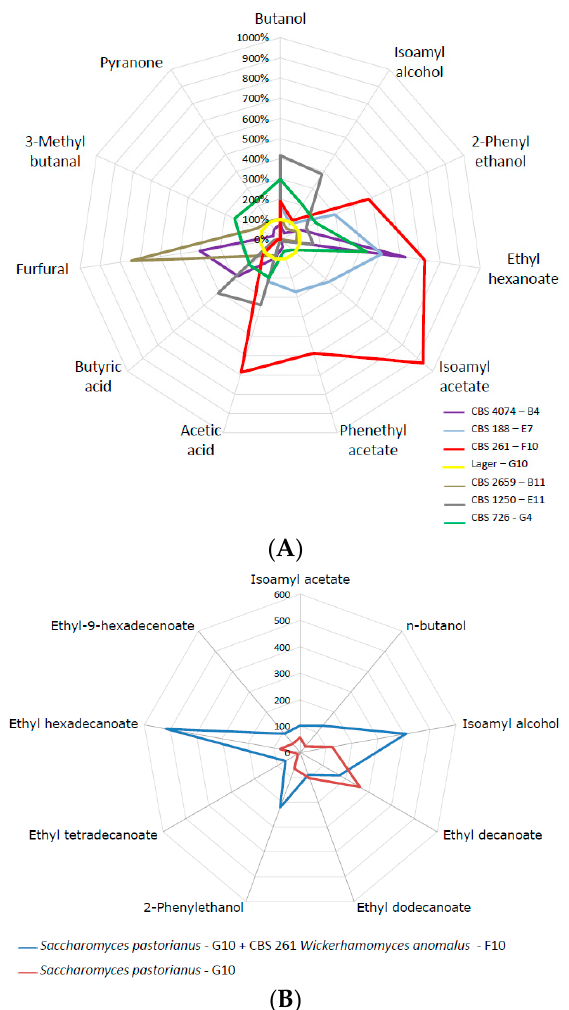
Figure 6. ( A ) Comparisons of selected volatiles of selected strains that produced exceptionally high concentrations of organic volatiles with the lager yeast reference. Strains used were: Candida diversa (CBS 4074, B4); Debaryomyces subglobosus (CBS 2659, B11); Pichia kluyveri (CBS 188, E7); Saccharomyces cerevisiae (CBS 1250; E11); Wickerhamomyces anomalus (CBS 261, F10); Zygosaccharomyces mellis (CBS 726, G4); Saccharomyces pastorianus (G10, reference). ( B ) Concentration of volatiles at the end of a co-fermentation using Wickerhamomyces anomalus (CBS 261, F10) and the Weihenstephan lager yeast (WS, Saccharomyces pastorianus G10, reference).